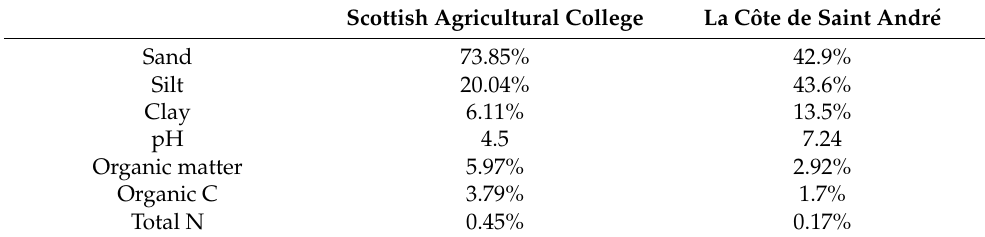
Table 1. Physical characterisation of the samples selected for this